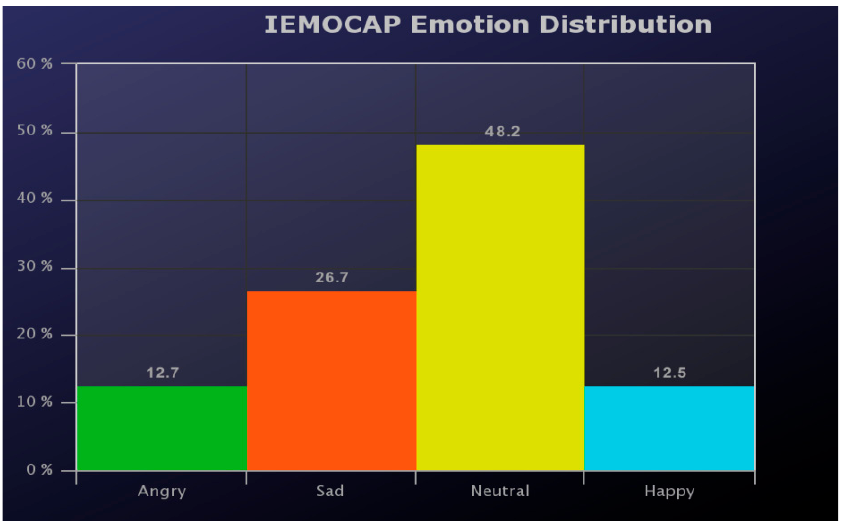
Figure 6. IEMOCAP emotion data